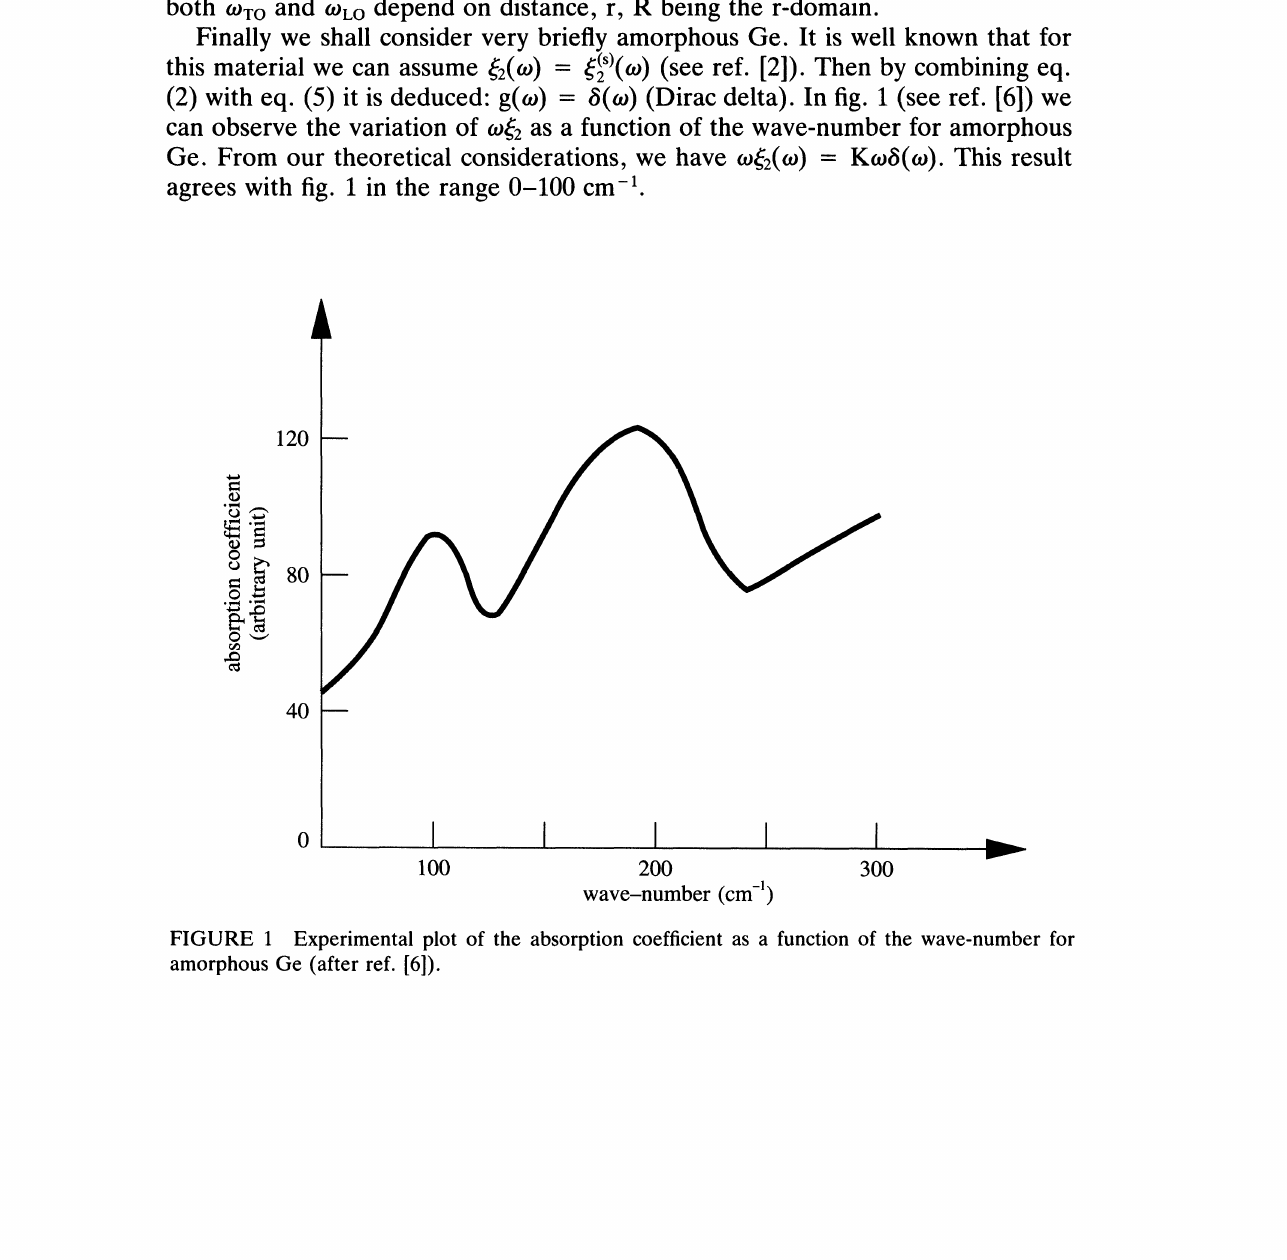
FIGURE Experimental plot of the absorption coefficient as a function of the wave-number for amorphous Ge (after ref.